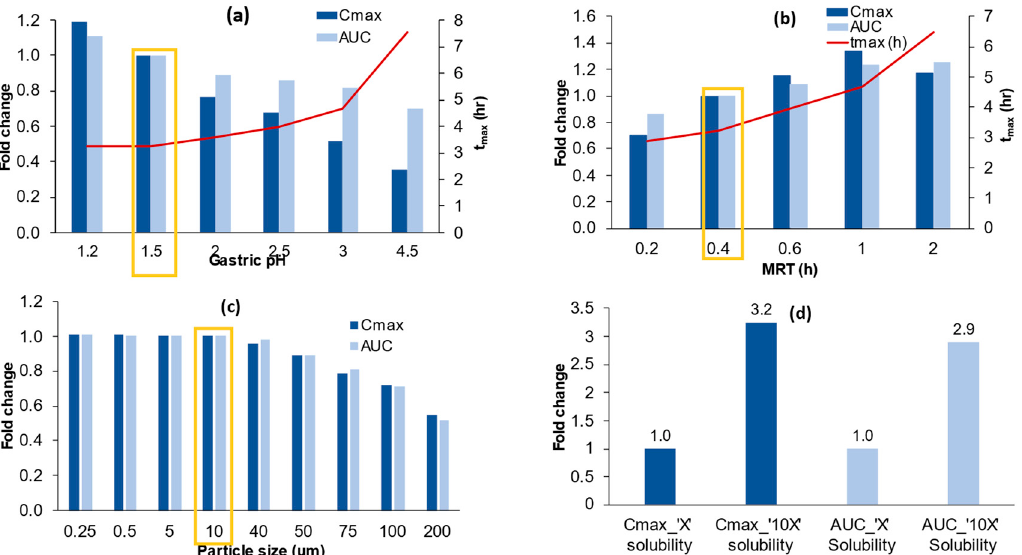
Figure 5. Simulated effect on pharmacokinetic parameters of changes in ( a ) gastric pH, ( b ) mean gastric residence time (MRT), ( c ) particle size, and ( d ) solubility (‘X’ and ‘10X’). The rectangular box represents the reference parameter used in the validation of the model.